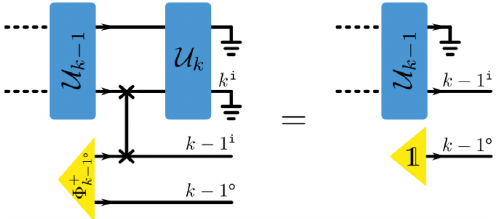
FIG. 18. Trace conditions on process tensors. Displayed is the pertinent part of Fig. 17. As tr ◦ U = tr for all CPTP maps U , , denoted by k i , tracing out the final degree of freedom of ϒ T k . This, in turn, yields a tensor amounts to a partial trace of (cid:20) + k − 1 o and a process tensor on one step less. As product between 1 k − 1 i in Fig. 17, the swap operation is represented by a vertical line with crosses at its